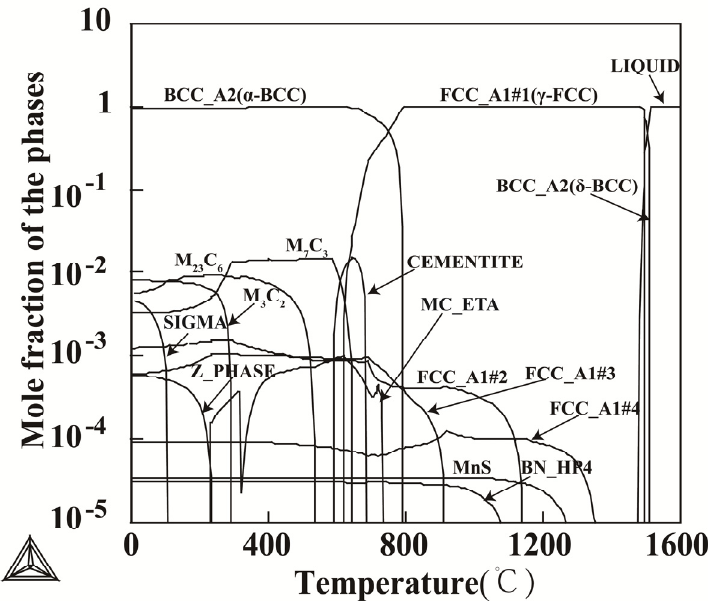
Figure 4. Equilibrium precipitates in SXQ500/550DZ35 steel.